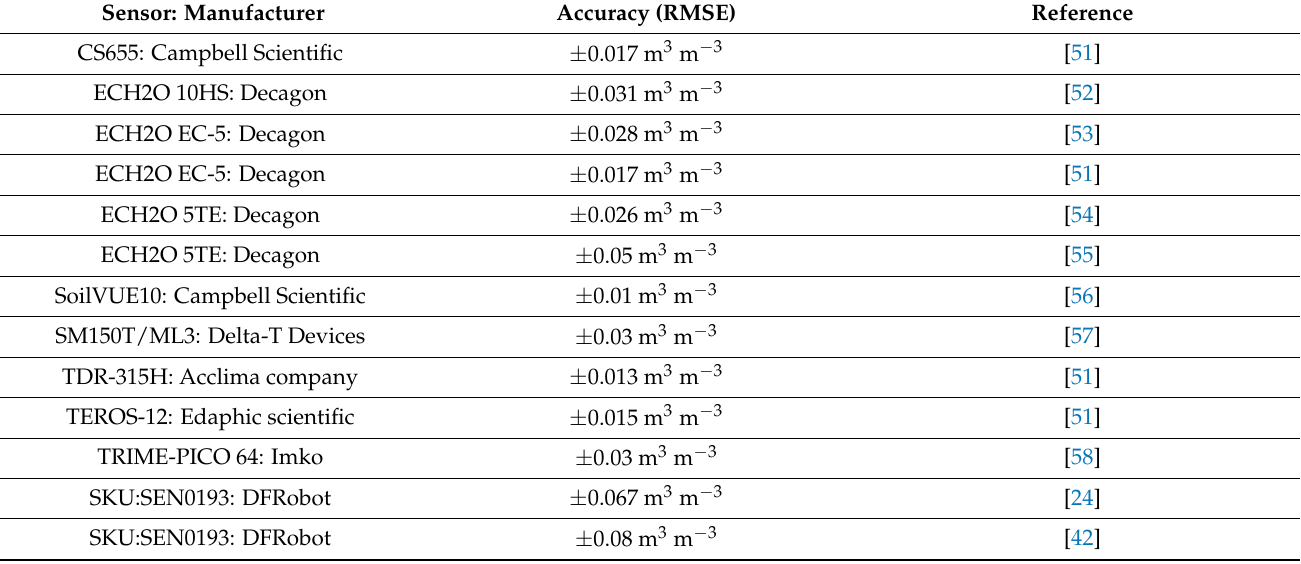
Table 6. Accuracy of different soil moisture